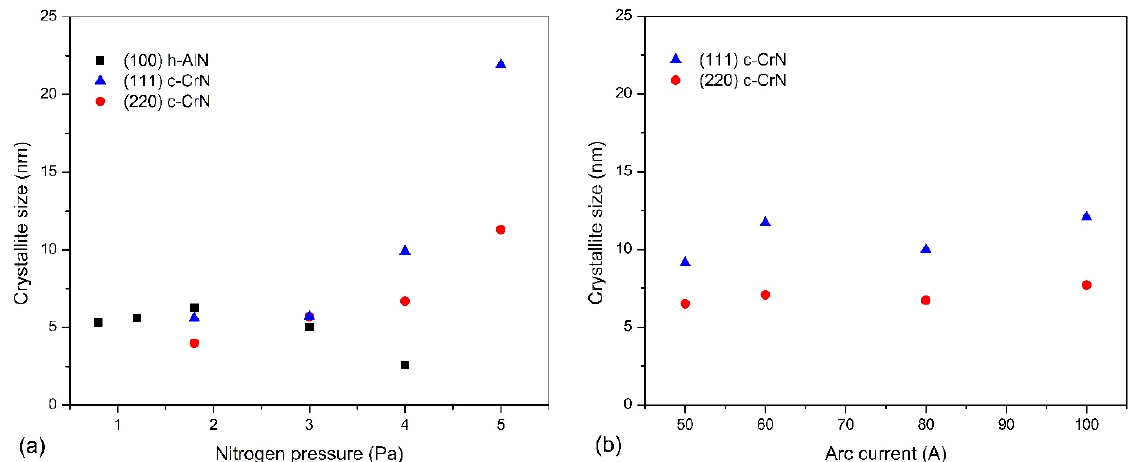
Figure 4. The crystallite size of (100) h-AlN and (111) and (220) c-CrN phases in AlCrN coating synthesized at: ( a ) different nitrogen pressure, ( b ) different arc current.